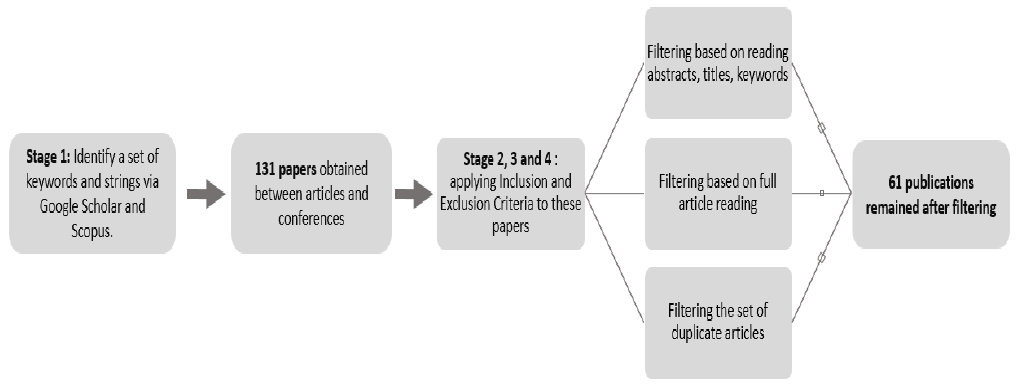
Figure 1. SLR stage iterations.